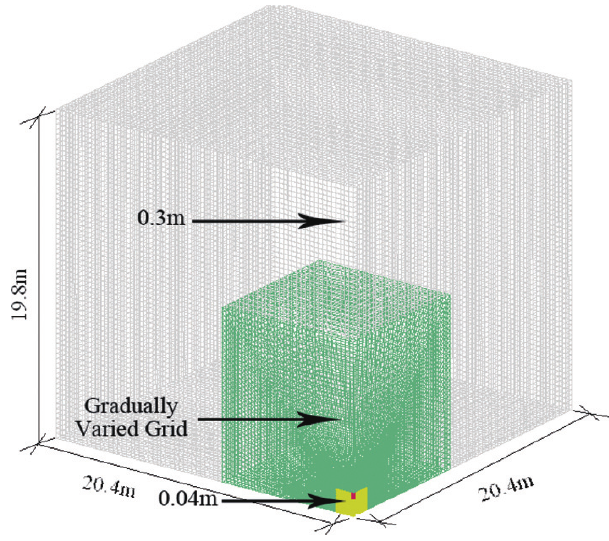
Fig. 1. Finite element model of air and